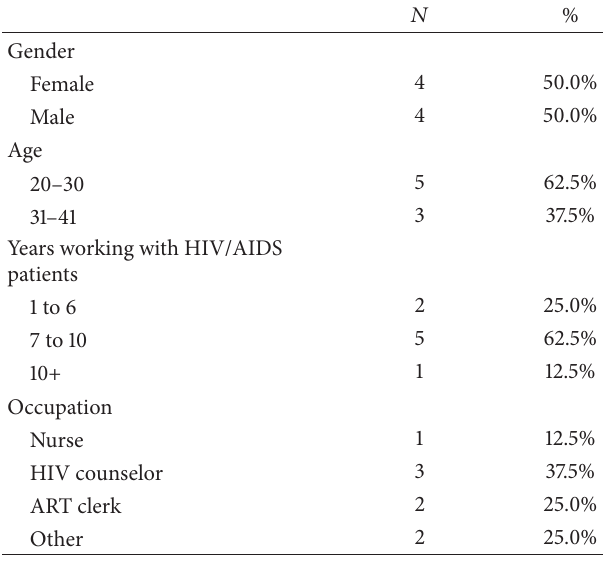
Table 1: Providers characteristics ( 𝑁 = 8